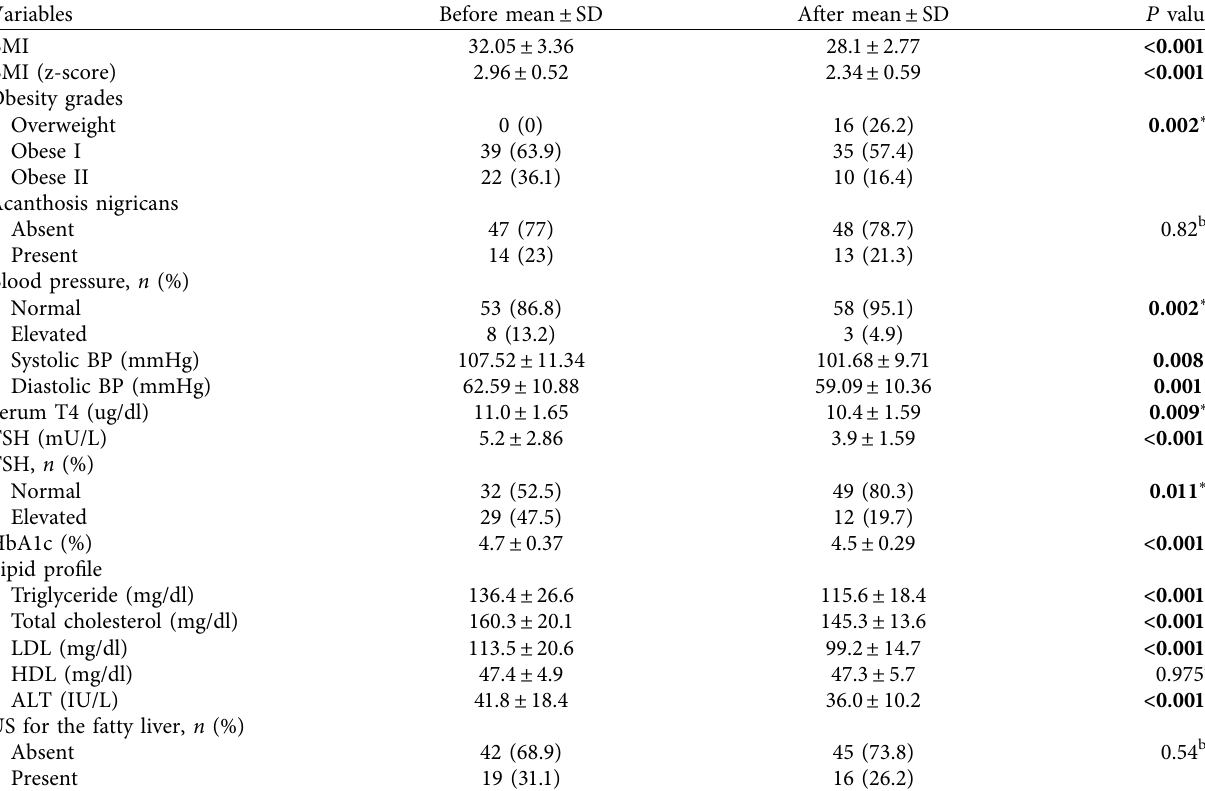
Table 2: Comparison of clinical, laboratory, and radiological variables of the studied participants before and after weight reduction measures.